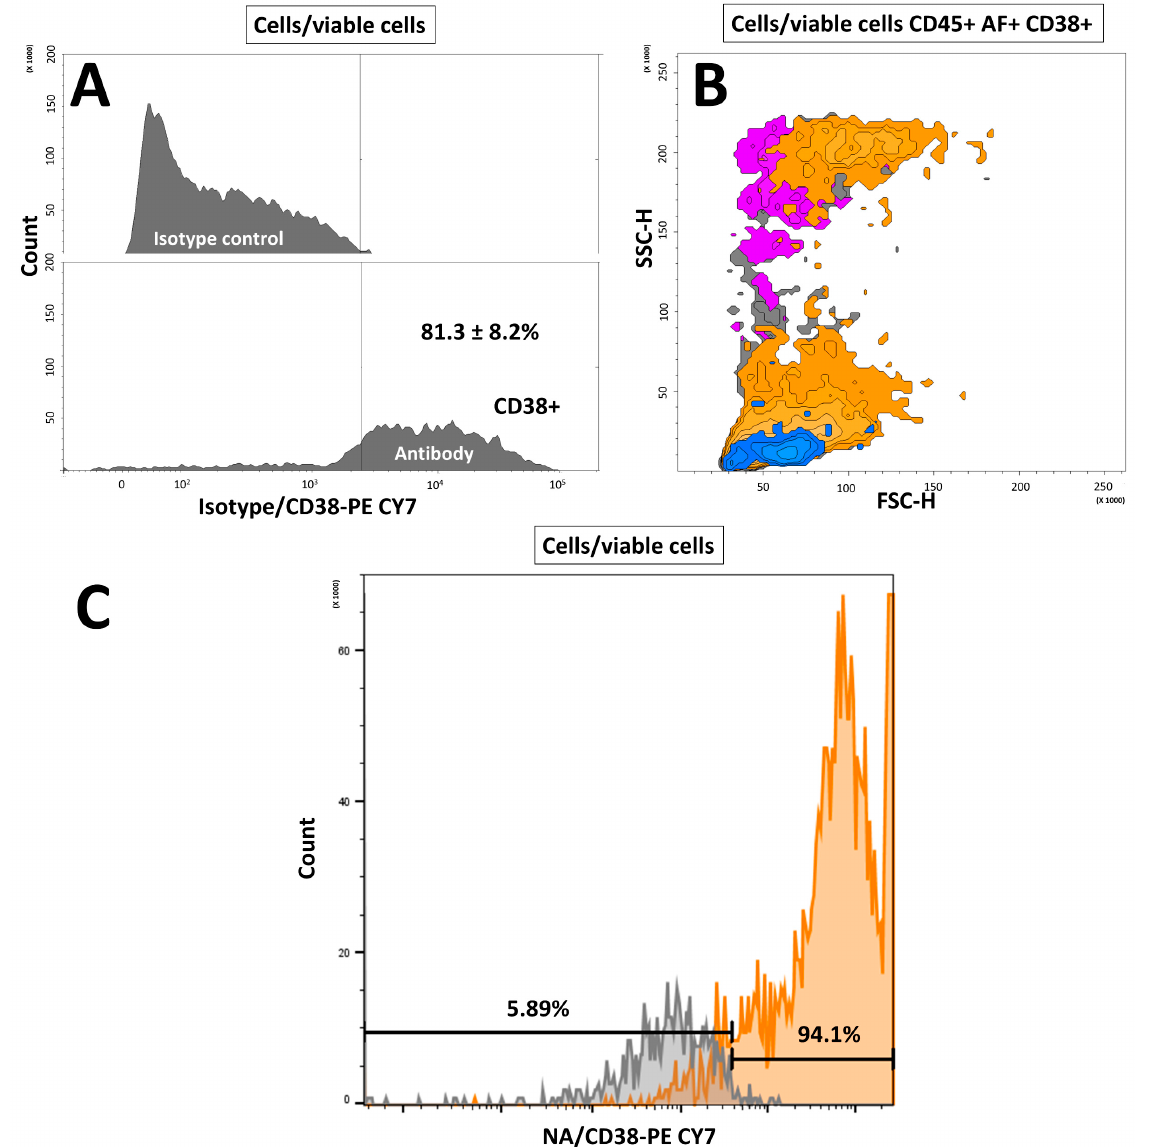
Figure 4. Assessment of CD38 expression on the hepatic stellate cell population sorted by MACS after the density gradient. ( A ) Histogram showing PE CY7 conjugated isotype (upper panel) or PE CY7 conjugated anti-mouse CD38 (lower panel) over cell count. The proportion is expressed as a mean ± SD, n = 3. ( B ) Backgating analysis of cell population morphology. Blue: CD45+ cells; violet: violet-induced autofluorescence (AF)+ cells; yellow: CD38+; gray: all viable cells (gate cell/viable cells). SSC: side scatter; FSC: forward scatter. ( C ) CD38 expression of HSC directly sorted from non-parenchymal cells according to their autofluorescence and morphology. Gray: without antibody; orange: CD38-PECY7 staining. n = 1, NA: no